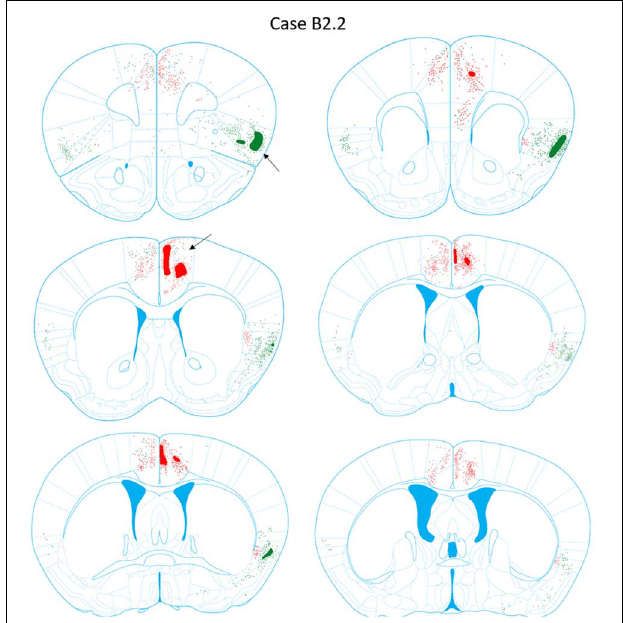
FIGURE 7 | Chartings of retrogradely labeled cells following viral injections into the aINS (green) and ACC (red) (case B2.2). The injection site cores are indicated by black arrows. The chartings were made onto plates modified from Paxinos and Watson (2014).